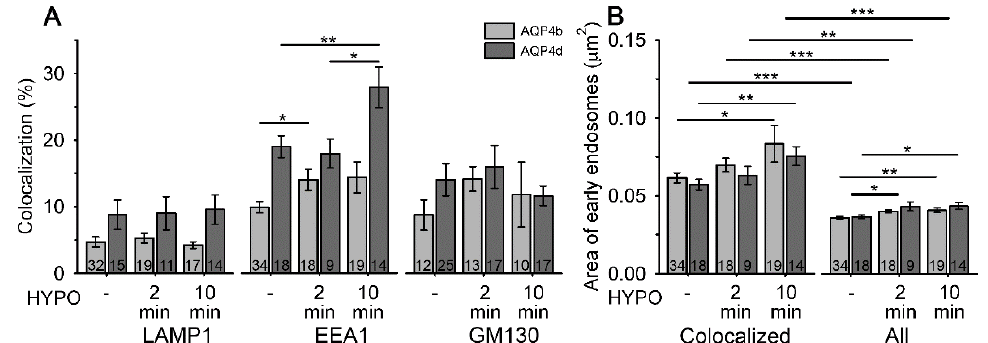
Figure 2. Hypoosmotic conditions trigger the redistribution of AQP4b and AQP4d to early endosomes and increase the area of early endosomes. ( A ) The percentage of colocalization between AQP4b and AQP4d, before and after hypoosmotic exposure, with late endosomes / lysosomes, early endosomes, and the Golgi apparatus, immunolabeled with lysosomal-associated membrane protein 1 (LAMP1), early endosome antigen 1 (EEA1), and Golgi membrane protein GM130, respectively. A significant increase in the colocalization between AQP4b and AQP4d with EEA1 was measured at 2 min (AQP4b) and 10 min (AQP4d) after hypoosmotic stimulation (HYPO) ( p = 0.03, Kruskal–Wallis test and p = 0.006, Holm–Sidak post hoc test, respectively). The percentage of colocalization of AQP4b and AQP4d with late endosomes / lysosomes and the Golgi apparatus remained similar with hypoosmotic stimulation ( p = 0.35 and p = 0.64, respectively, in endosomes / lysosomes; and p = 0.07 and p = 0.8, respectively, in the Golgi apparatus; Kruskal–Wallis test). ( B ) The average area of early endosomes containing (colocalized) AQP4b and AQP4d isoforms and all endosomes in the cell before and after hypoosmotic exposure in transfected astrocytes. The average area of early endosomes containing AQP4b and AQP4d was significantly larger 10 min after hypoosmotic stimulation ( p < 0.05, Kruskal–Wallis test and p = 0.009, Holm–Sidak post hoc test, respectively). Similarly, the average area of all early endosomes in AQP4b- and AQP4d-transfected cells was significantly larger after 2 and 10 min (AQP4b, p = 0.01 and p = 0.002, respectively; AQP4d, p = 0.01 and p = 0.03, respectively, Holm–Sidak post hoc test). Early endosomes containing either AQP4b or AQP4d were twofold larger than all early endosomes ( p < 0.001, Mann–Whitney test, p = 0.007, Student’s t test). Thin lines represent statistical significance between solely AQP4b or AQP4d groups, while thicker lines represent statistical significance observed in both groups containing both isoforms. Data represent means ± standard error of the mean from three (AQP4b) and two (AQP4d) independent experiments (animals). * p < 0.05, ** p < 0.01, and *** p <